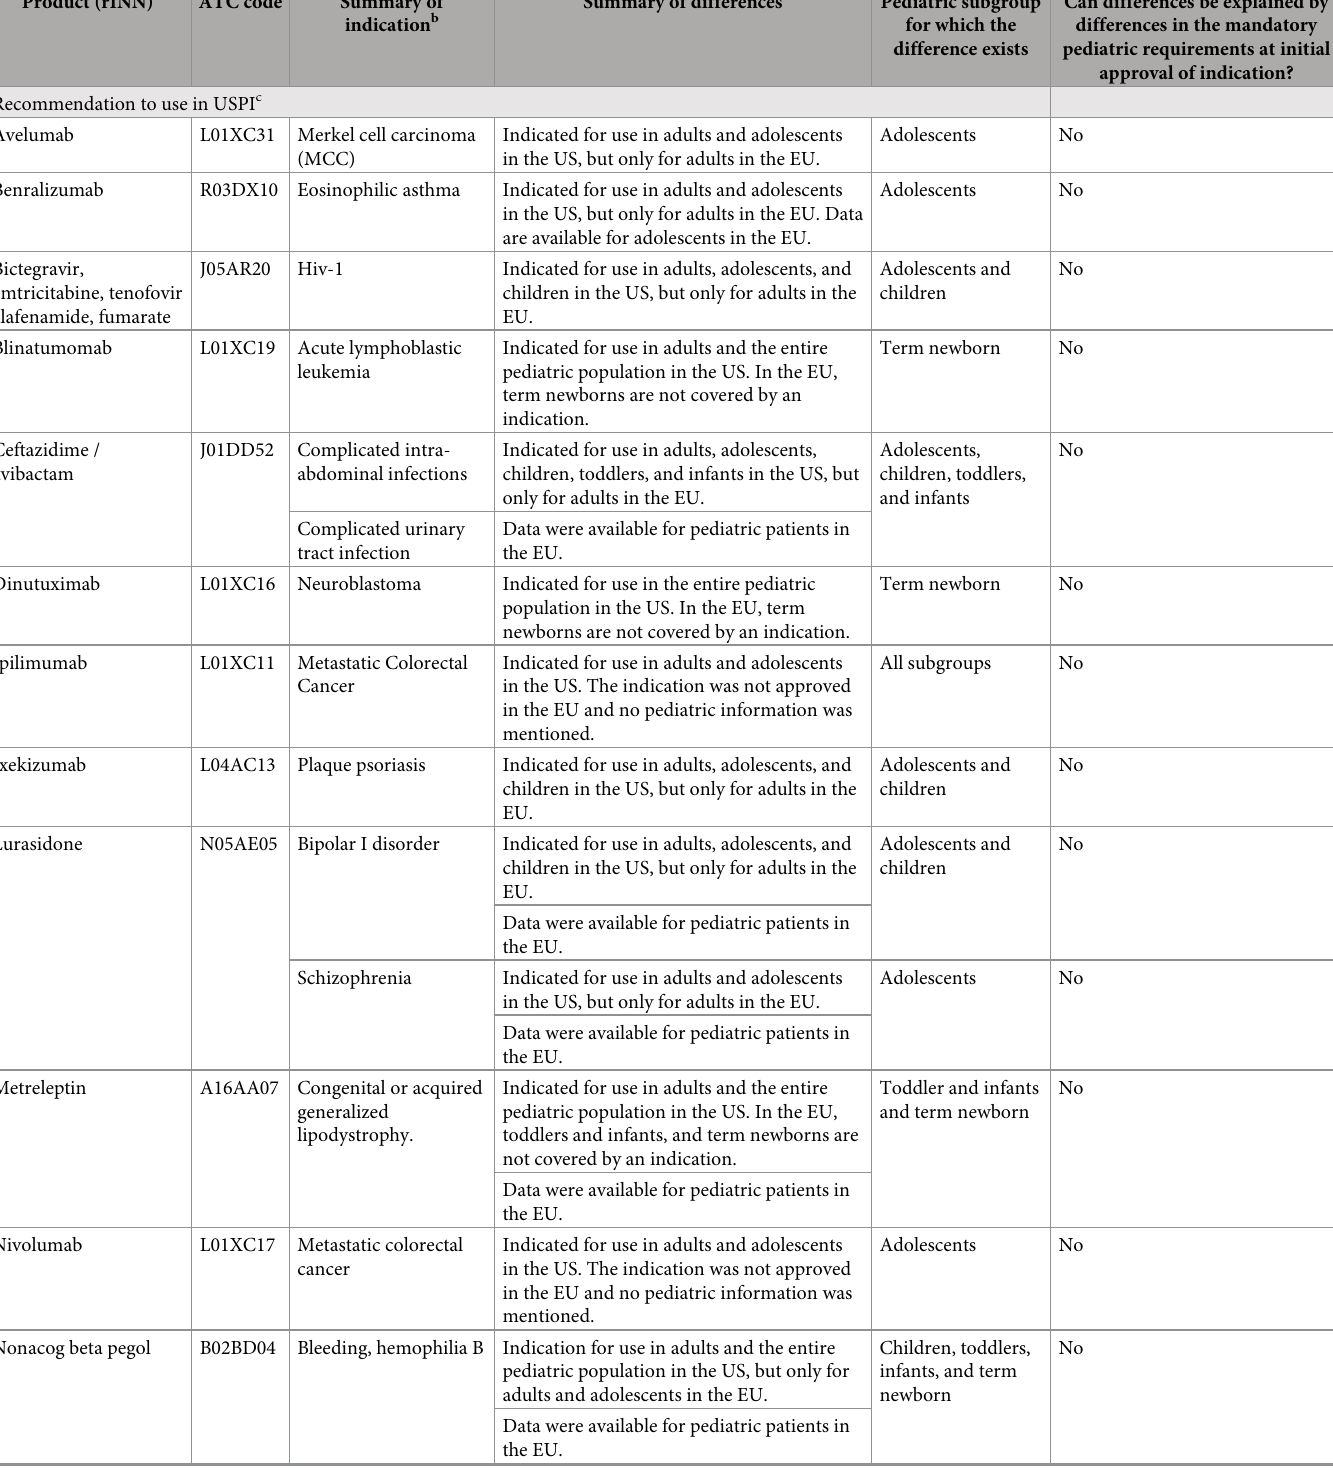
Table 6. Summary of discrepancies in the guidance for pediatric use for indications where USPI provides more guidance than SmPC a ( n = 30). Ordered by guidance for pediatric use in the US and alphabetically by active substances